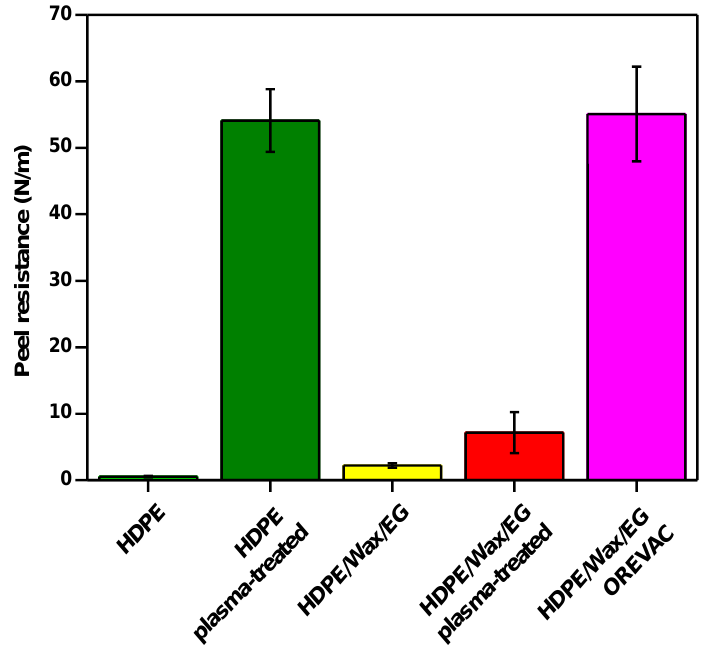
Figure 6. Peel test of SSPCMs samples with Al.